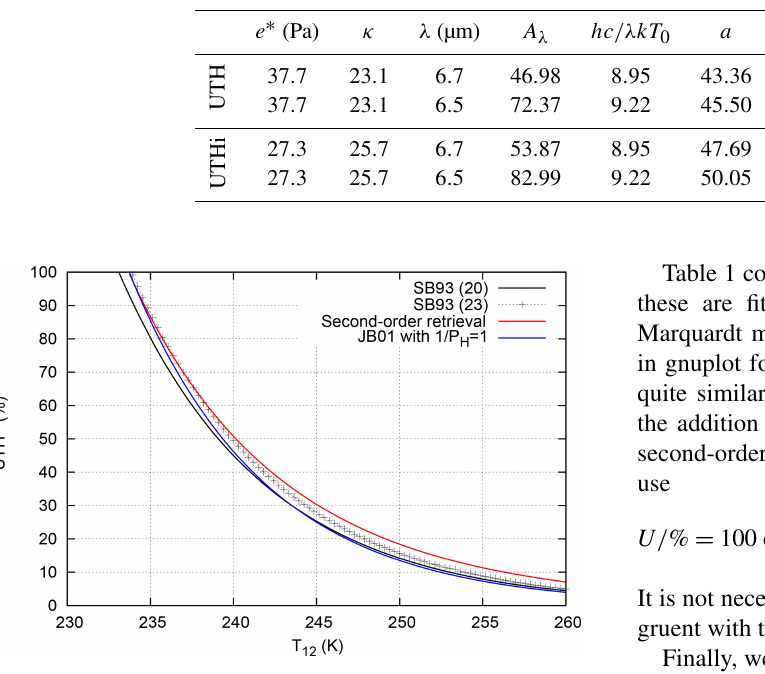
Table 1. Constants used for the two different central wavelengths of HIRS channel 12 and fit coefficients.